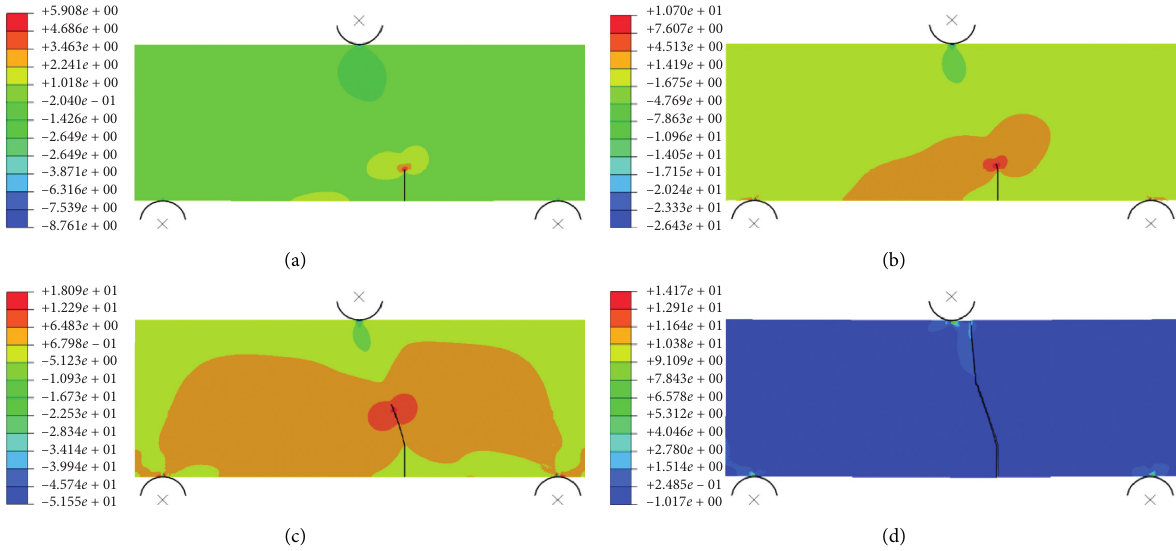
Figure 6: The crack processes and maximum principal stress under the loading displacement: (a) 0.018 mm; (b) 0.036 mm; (c) 0.073 mm; (d) 0.38 mm.